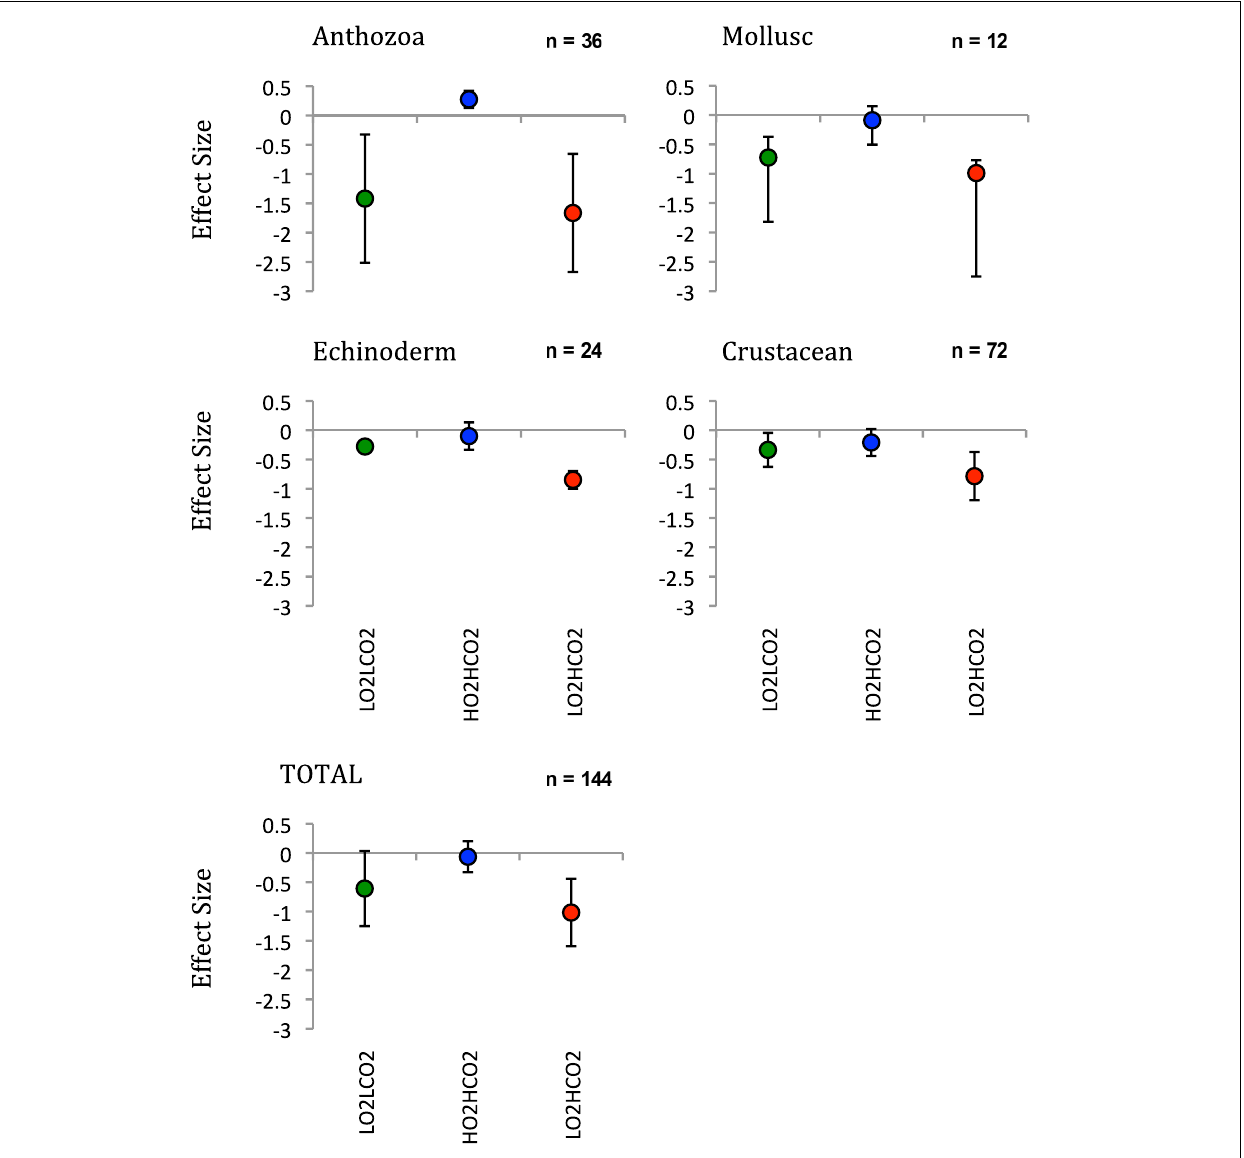
FIGURE 2 | Effect size off of the respiration rate of taxonomic groups calculated with dry weight after 6 days. LnRR = ln(treatment - H O2 L CO2 ) ± Confidence interval (after Kroeker et al.,